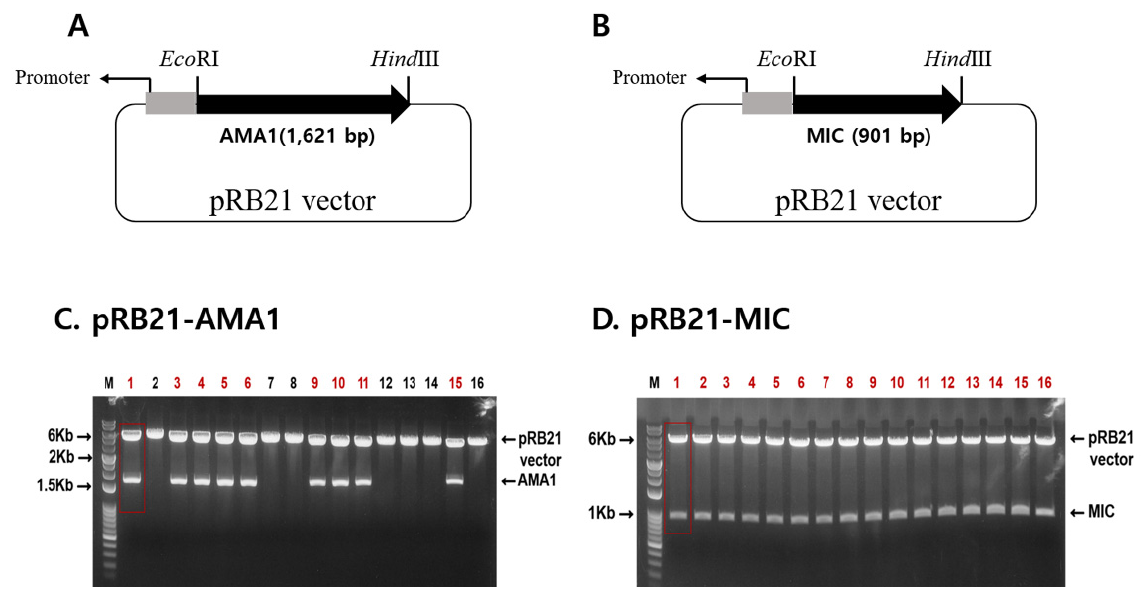
Figure 1. Gene cloning. To generate P. berghei AMA1 and MIC recombinant vaccinia virus (rVV), gene cassettes with promoters and recombination sites were designed, shown as a schematic diagram ( A , B ). PbAMA1 or PbMIC genes were cloned into the pRB21 vector, and clones pRB21-AMA1 ( C ) and pRB21-MIC ( D ) were confirmed by restrictive enzyme digestion with EcoR I and Hind III. The red color font denotes successful clones.